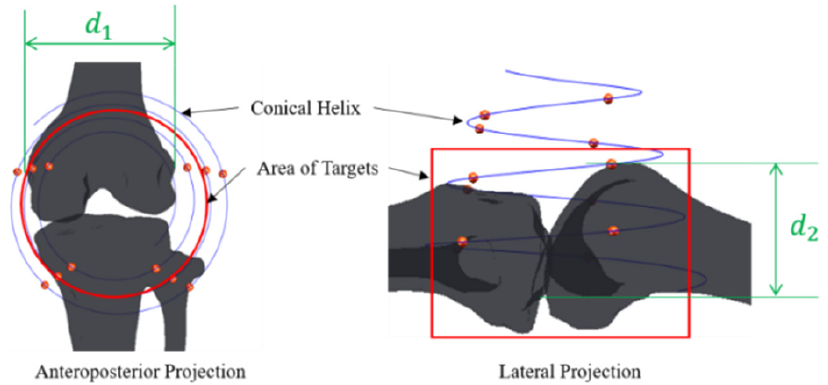
Figure 4. A conical spiral curve model of markers on calibration phantom.